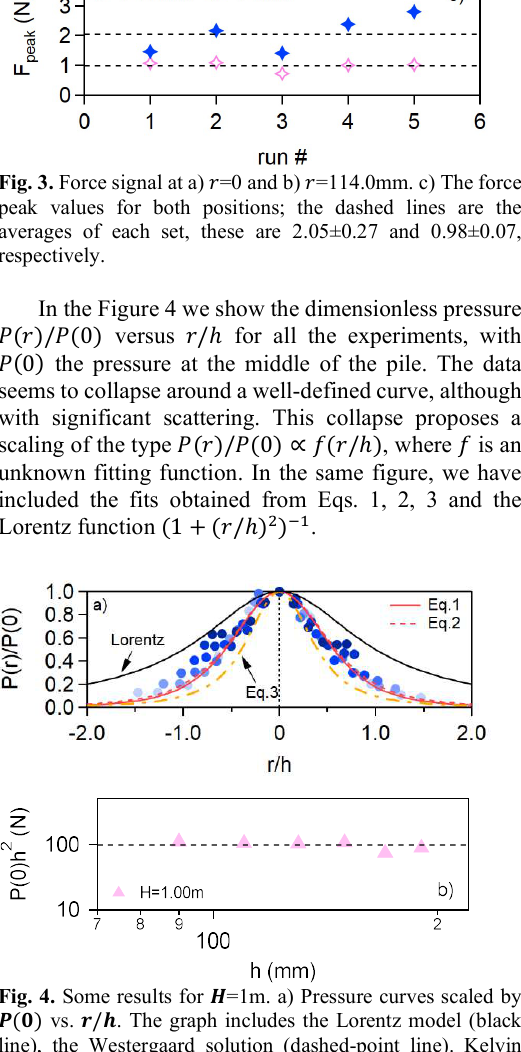
both parameters for different drop heights, showing the decreasing law as expected.